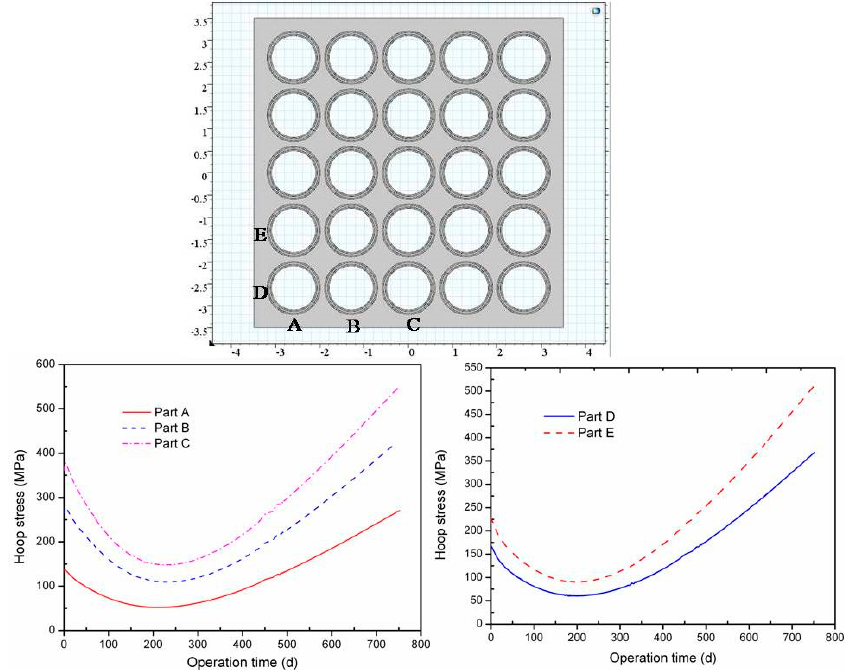
Figure 8. Variation of the hoop stress of the SiC matrix located in the marginal parts of the FCM pallet.